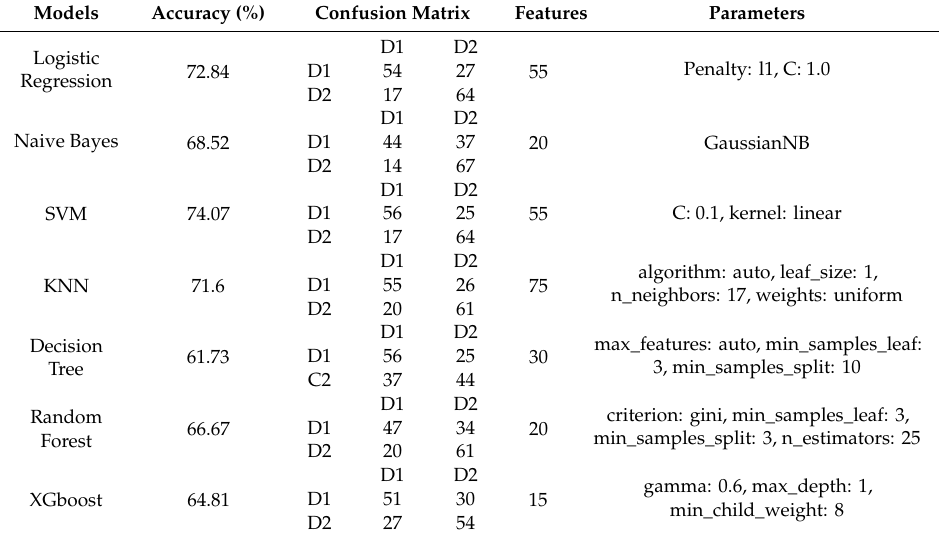
Figure 10. Learning curves with testing accuracy scores on dataset D for different ML models trained on feature subsets of increasing dimensionality. Table 7. Best testing accuracies achieved for each ML model along with the confusion matrix, the optimum number of features and the hyperparameters of the ML models employed. D1 and D2 denote classes 1 and 2 of dataset D, respectively.